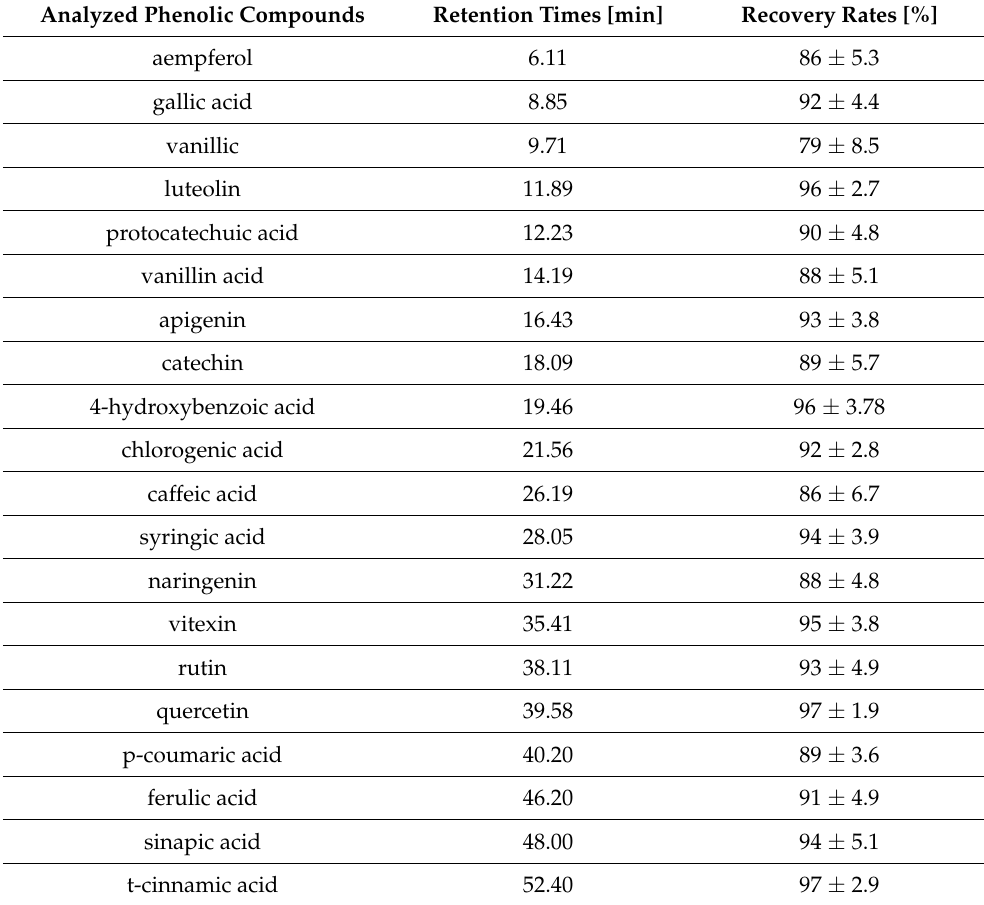
Table 4. Retention times and recovery rates for the analyzed phenolic